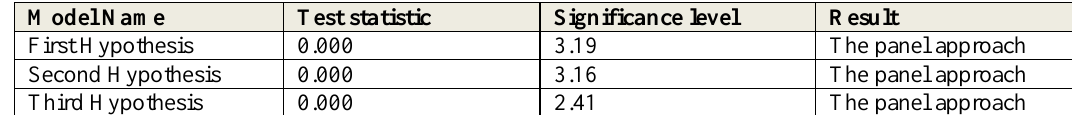
Table 7. F- Limer test results